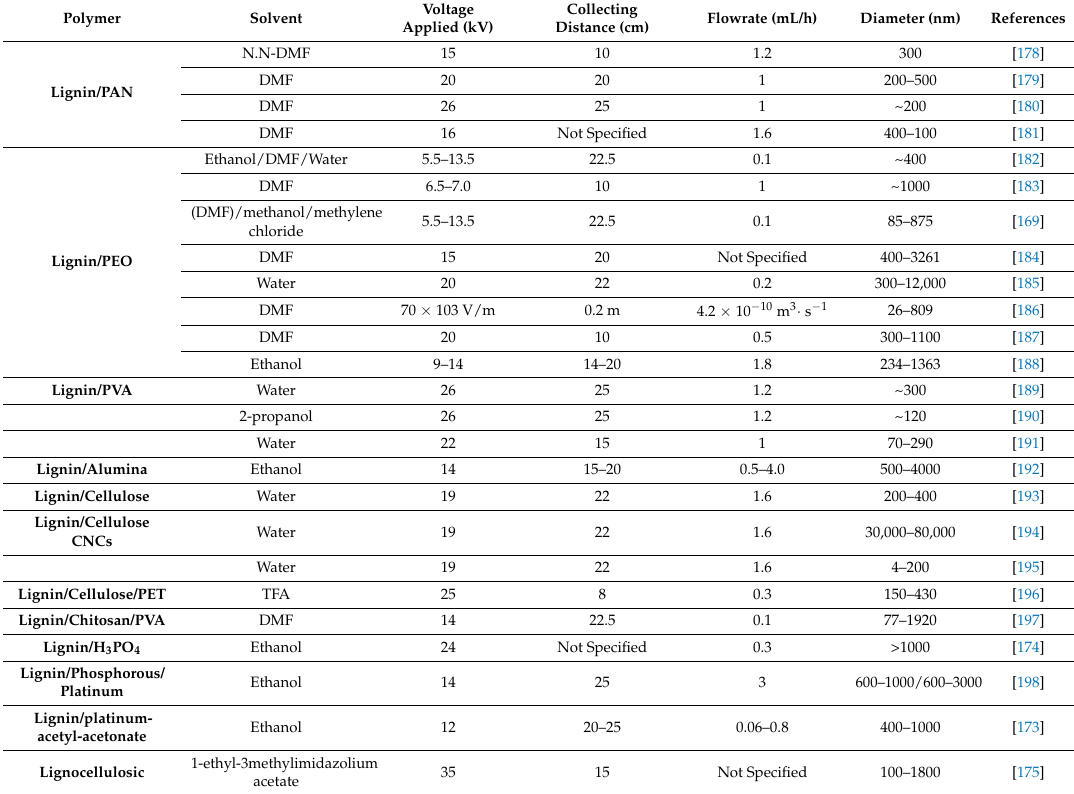
Table 2. Summary of electrospinning parameters of lignin, lignin/carrier polymer, and their fiber dimensions. Polymer Solvent Voltage Applied (kV)